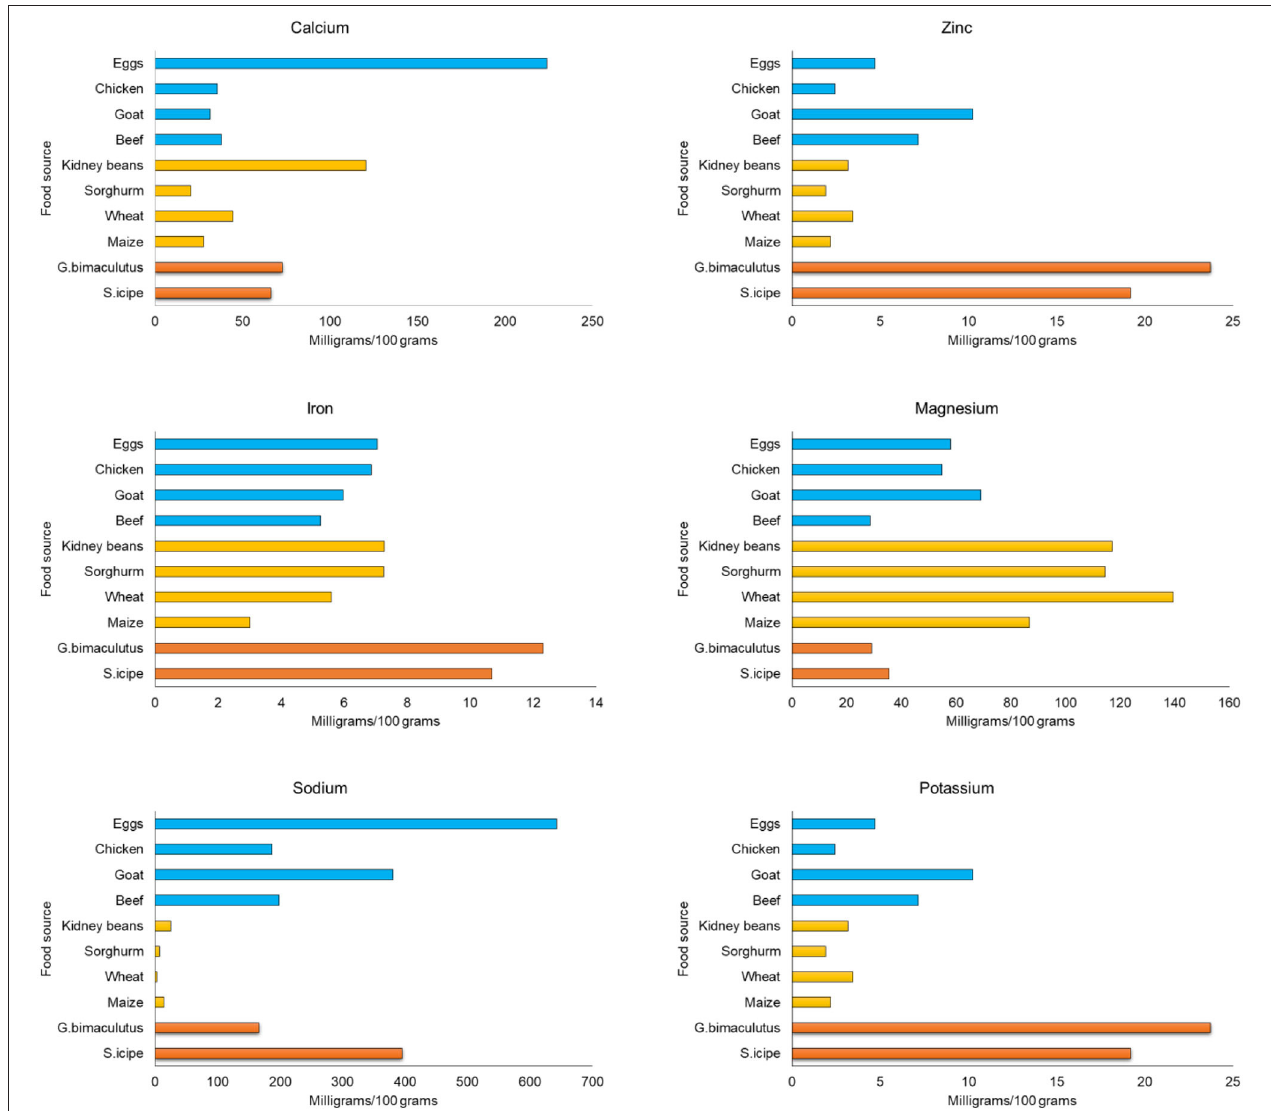
FIGURE 4 | Comparison of mineral content of crickets ( Scapsipedus icipe and Gryllus bimaculatus ), animal and plant-based sources. Mineral content data for plant and animal food sources was extracted from FAO/GoK (31), while that of the recommended nutrient intake (RNI) was obtained from FAO/WHO/UNU (56).